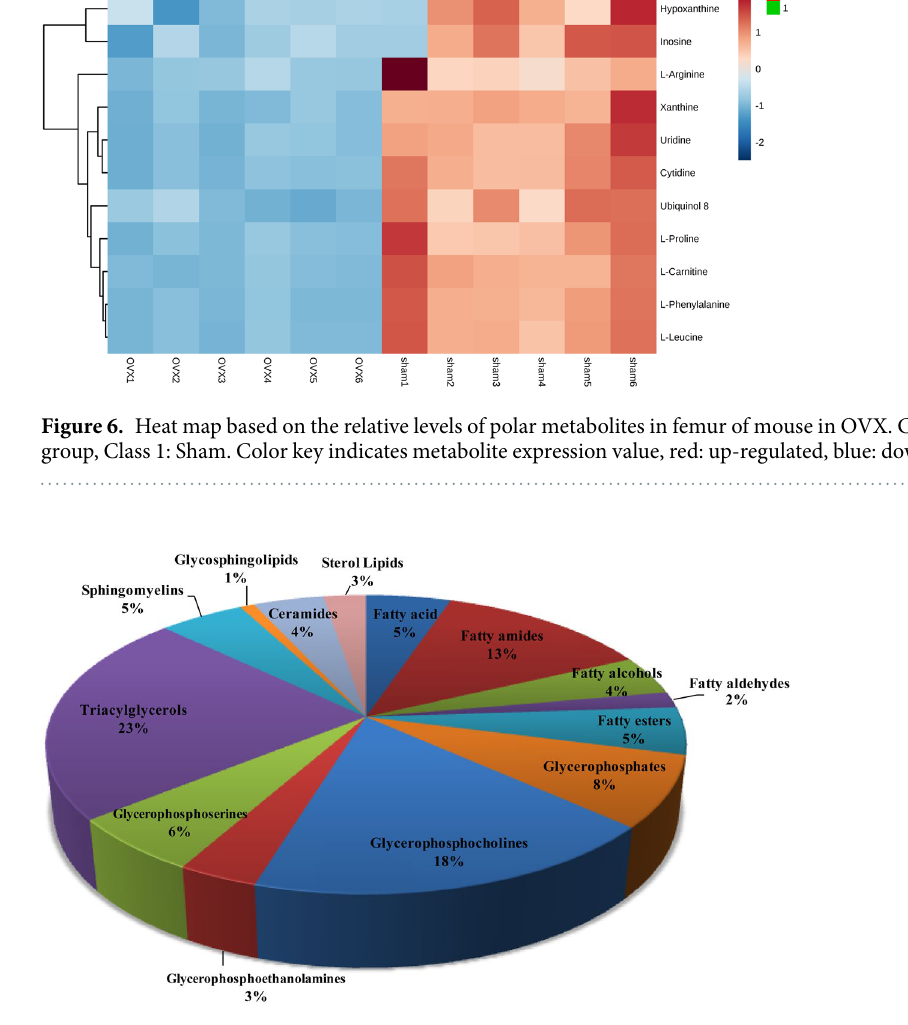
Figure 7. The proportion of different lipid categories.